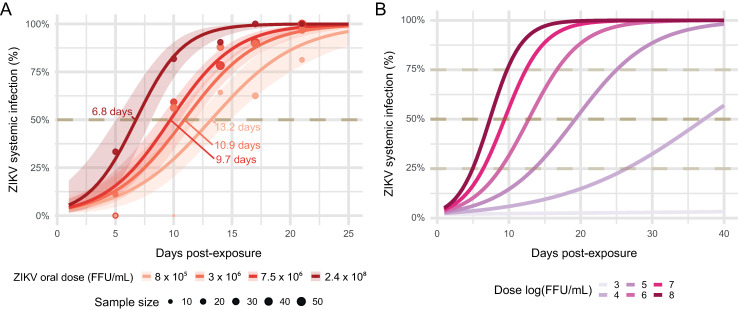
Ae. albopictus mosquito systemic infection rate dynamic post-virus exposure as a function of the oral dose.(A) Systemic infection rate dynamics observed experimentally. Dots correspond to systemic infection rates observed on Ae. albopictus mosquitoes at each infectious blood-meal titer. Dots size is proportional to the number of samples. The time-dependent effect of the virus dose on systemic infection rates was modelled using logistic regression. Lines correspond to fit values with their 95% confidence intervals displayed as ribbons. (B) Predicted systemic infection rate dynamics according to the virus dose and time post-virus exposure for a range of infectious blood meal titers (3 to 8 log10 FFU/mL).